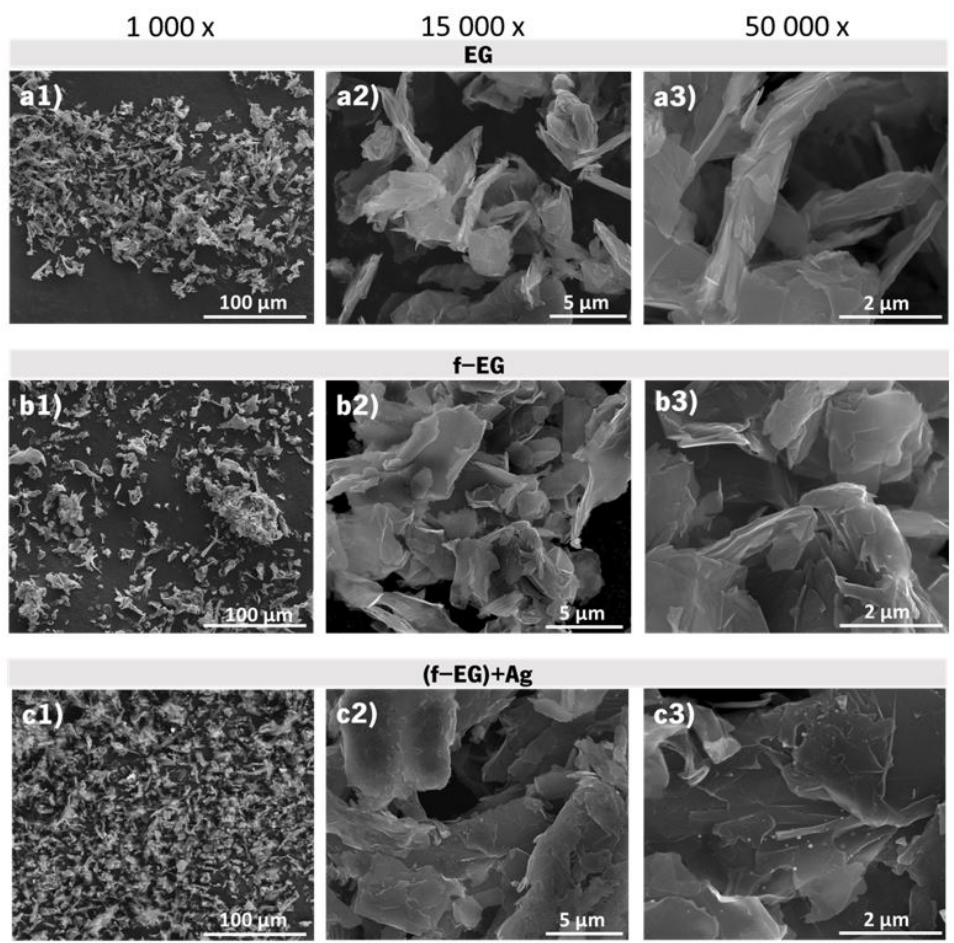
Figure 7. SEM images for pristine EG at different magnifications: ( a1 – a3 ); f-EG: ( b1 – b3 ) and [(f-